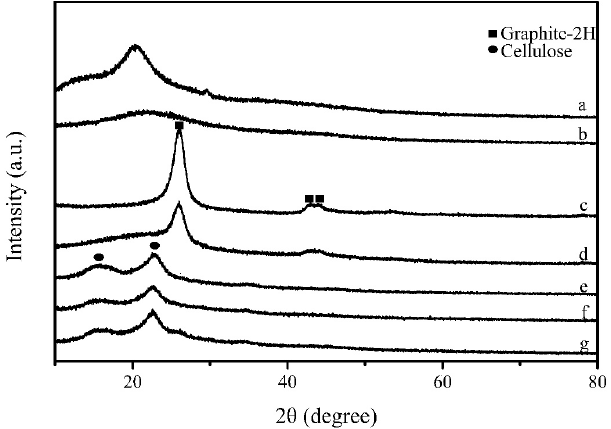
Figure 3. XRD patterns of CS ( a ); GC ( b ); MWCNT ( c ); GC/MWCNT ( d ); LC composite ( e ); LC/GC composite ( f ); LC/GC/MWCNT composite( g ).